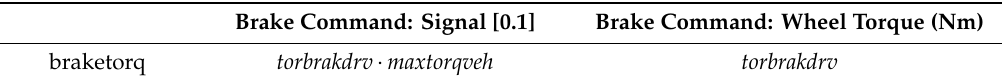
Table 3. Brake command.